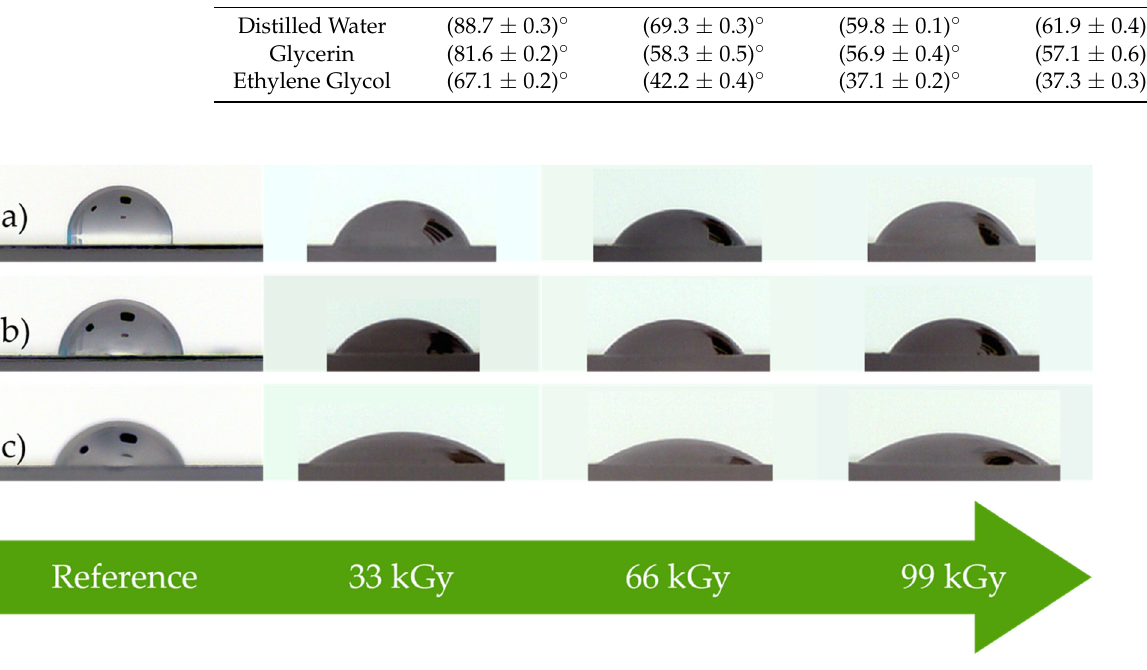
Figure 5. Liquid droplets on surfaces of test material (depending on radiation dose): ( a ) distilled water, ( b ) glycerin, and ( c ) ethylene glycol.